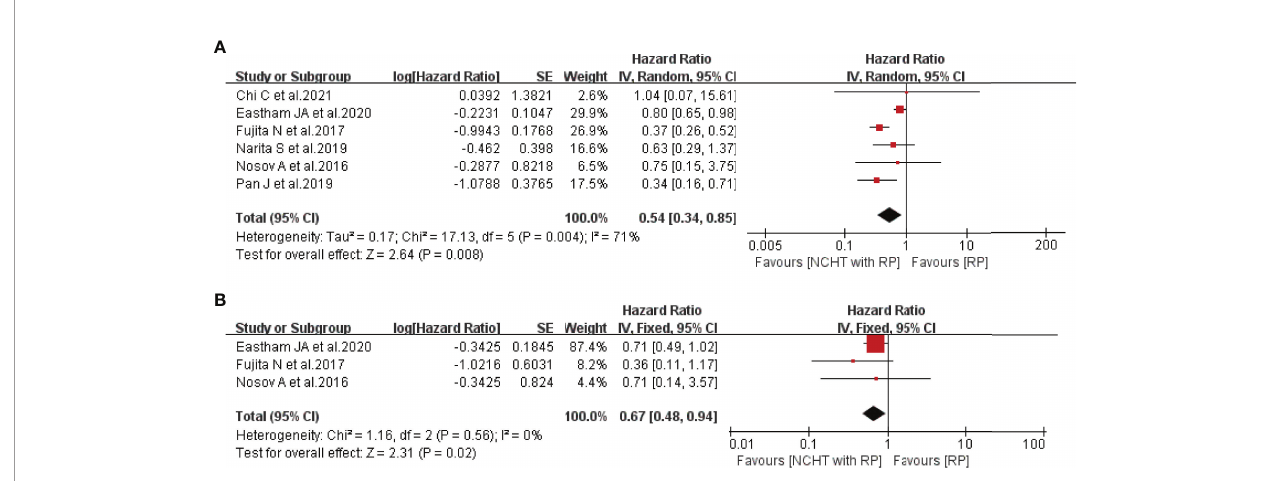
FIGURE 3 | Forest plot of hazard ratios for survival outcomes with NCHT plus RP compared with RP alone. (A) biochemical recurrence-free survival, (B) overall survival. NCHT, neoadjuvant chemohormonal therapy; RP, radical prostatectomy; CI, con fi dence interval, SE, standard